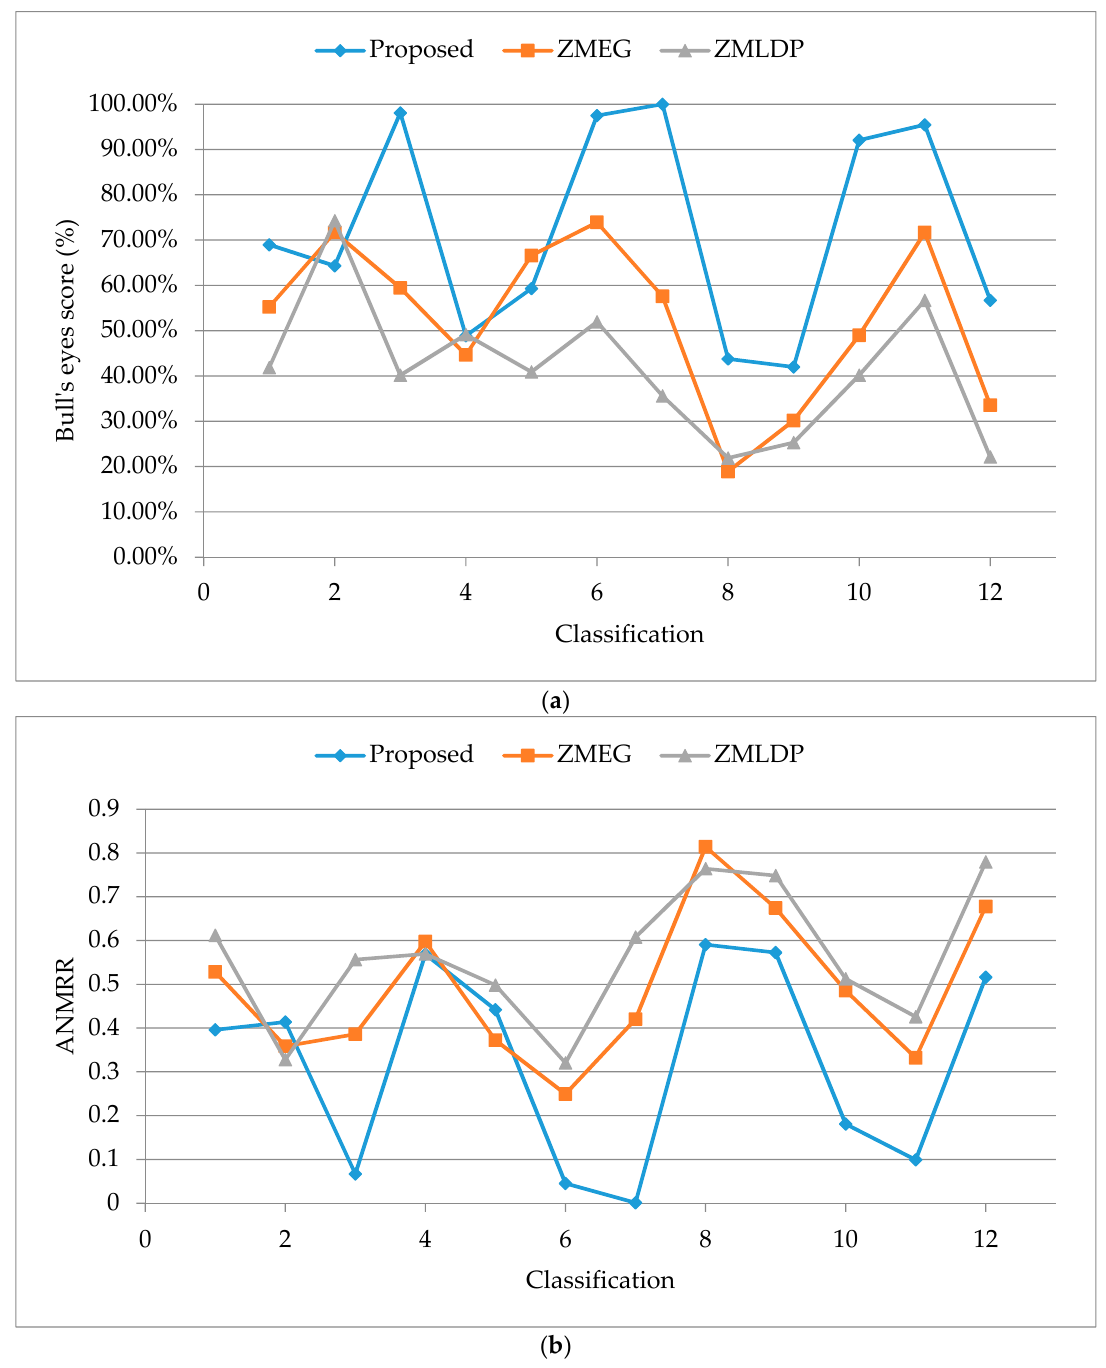
Figure 12. Comparison of the Bull’s eye and ANMRR scores of all classifications in the database. ( a ) The Bull’s eye scores. ( b ) The ANMRR scores.